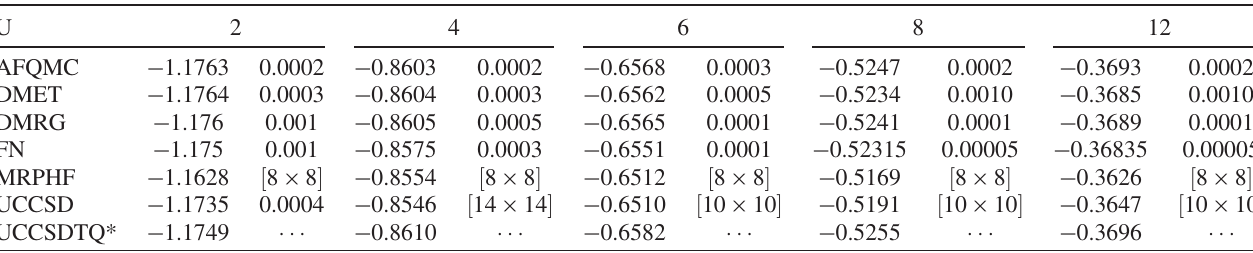
TABLE II. Zero-temperature energy and uncertainty for n ¼ 1 , T ¼ 0 , for a range of interaction strengths U , obtained from AFQMC, DMET, DMRG, FN, MRPHF, and UCCSD. Where extrapolations to the TL are not available, finite-size geometries are listed in lieu of uncertainties. UCCSDTQ* data estimate higher-order corrections by including triples from a ½ 6 × 6 (cid:4) and quadruples from a ½ 4 × 4 (cid:4) . UCCSD data for U=t > 4 provide nearly converged energy estimates with respect to system size.